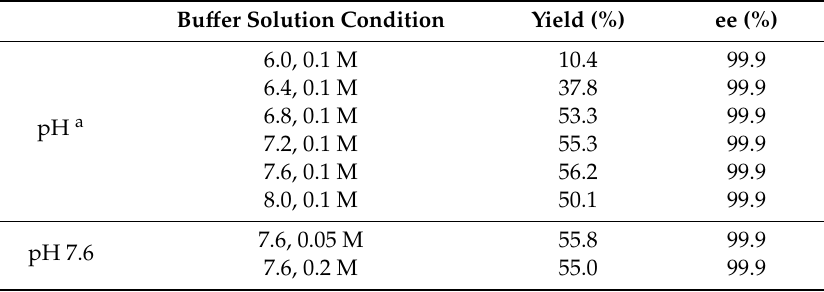
Table 3. E ff ect of bu ff er pH on the asymmetric reduction.